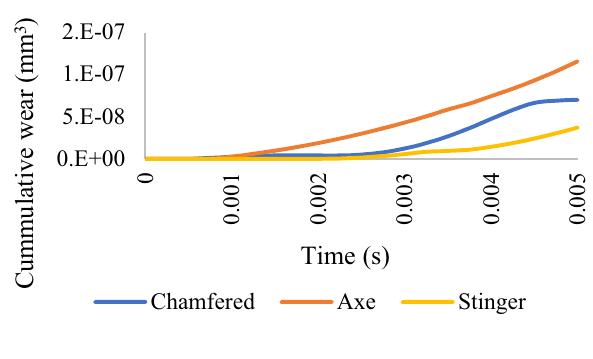
Fig. 14 Cumulative wear versus time with water-based mud